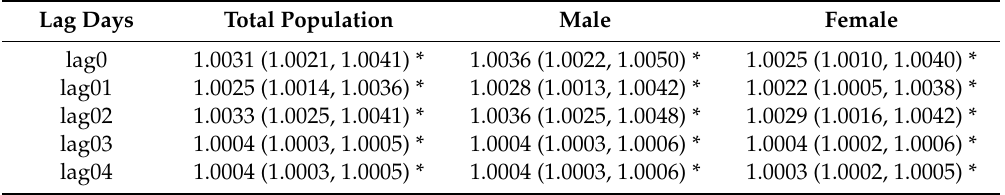
Table 3. Relative risk (RR) and 95% confidence interval (CI) of the PM 2.5 exposure and mortality of circulatory diseases in di ff erent lagging